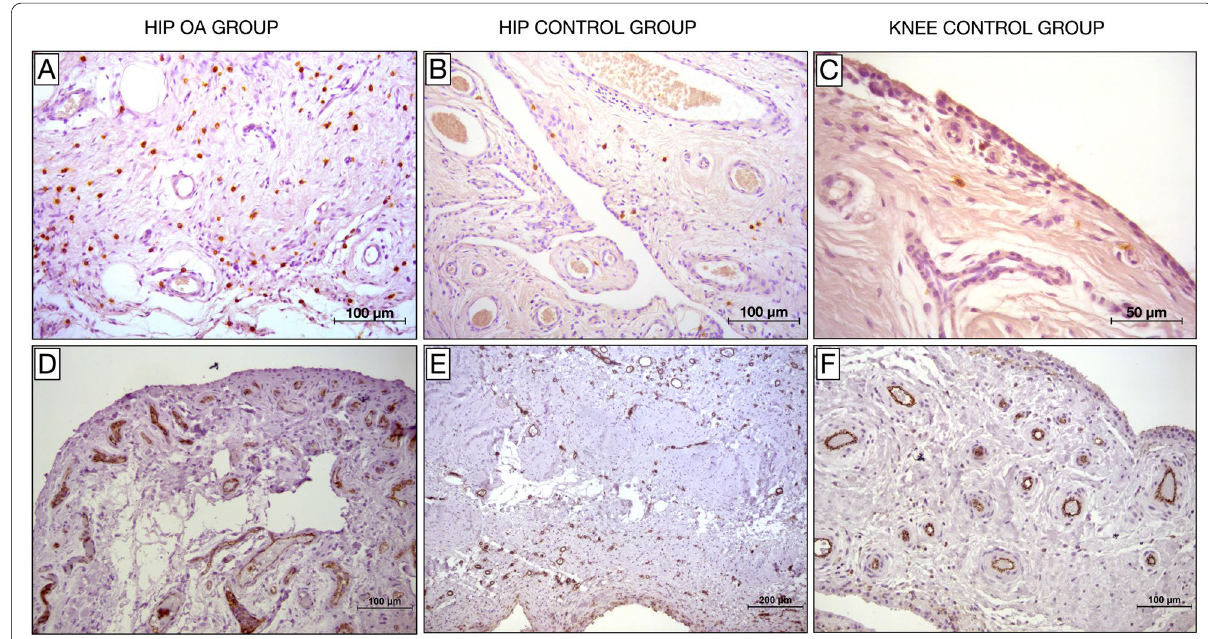
Fig. 5 Samples from patients with hip osteoarthritis and from hip and knee control groups. A, B and C . Paraffin sections stained for CD117. Mast cells are identified by brown reaction product. B and C. Low grade of synovial inflammation. A and B , 20 E and F . Paraffin sections stained for CD31. Vessels are identified by brown reaction product. Significant synovial hypervascularity can be seen in